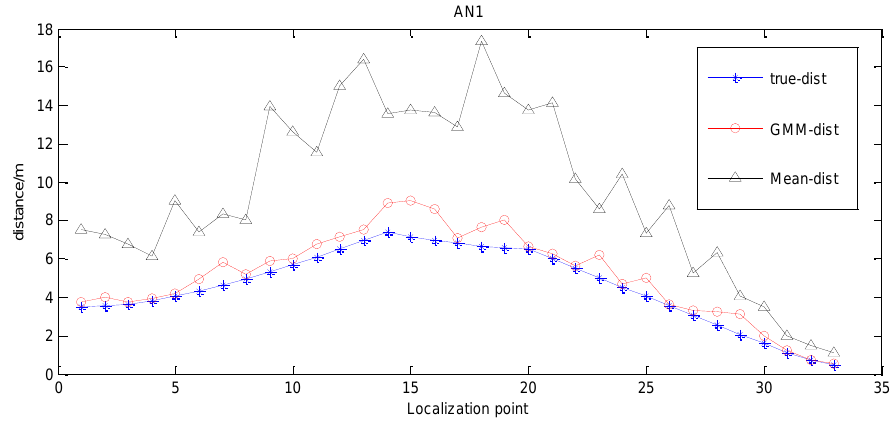
Figure 5. Result of distance